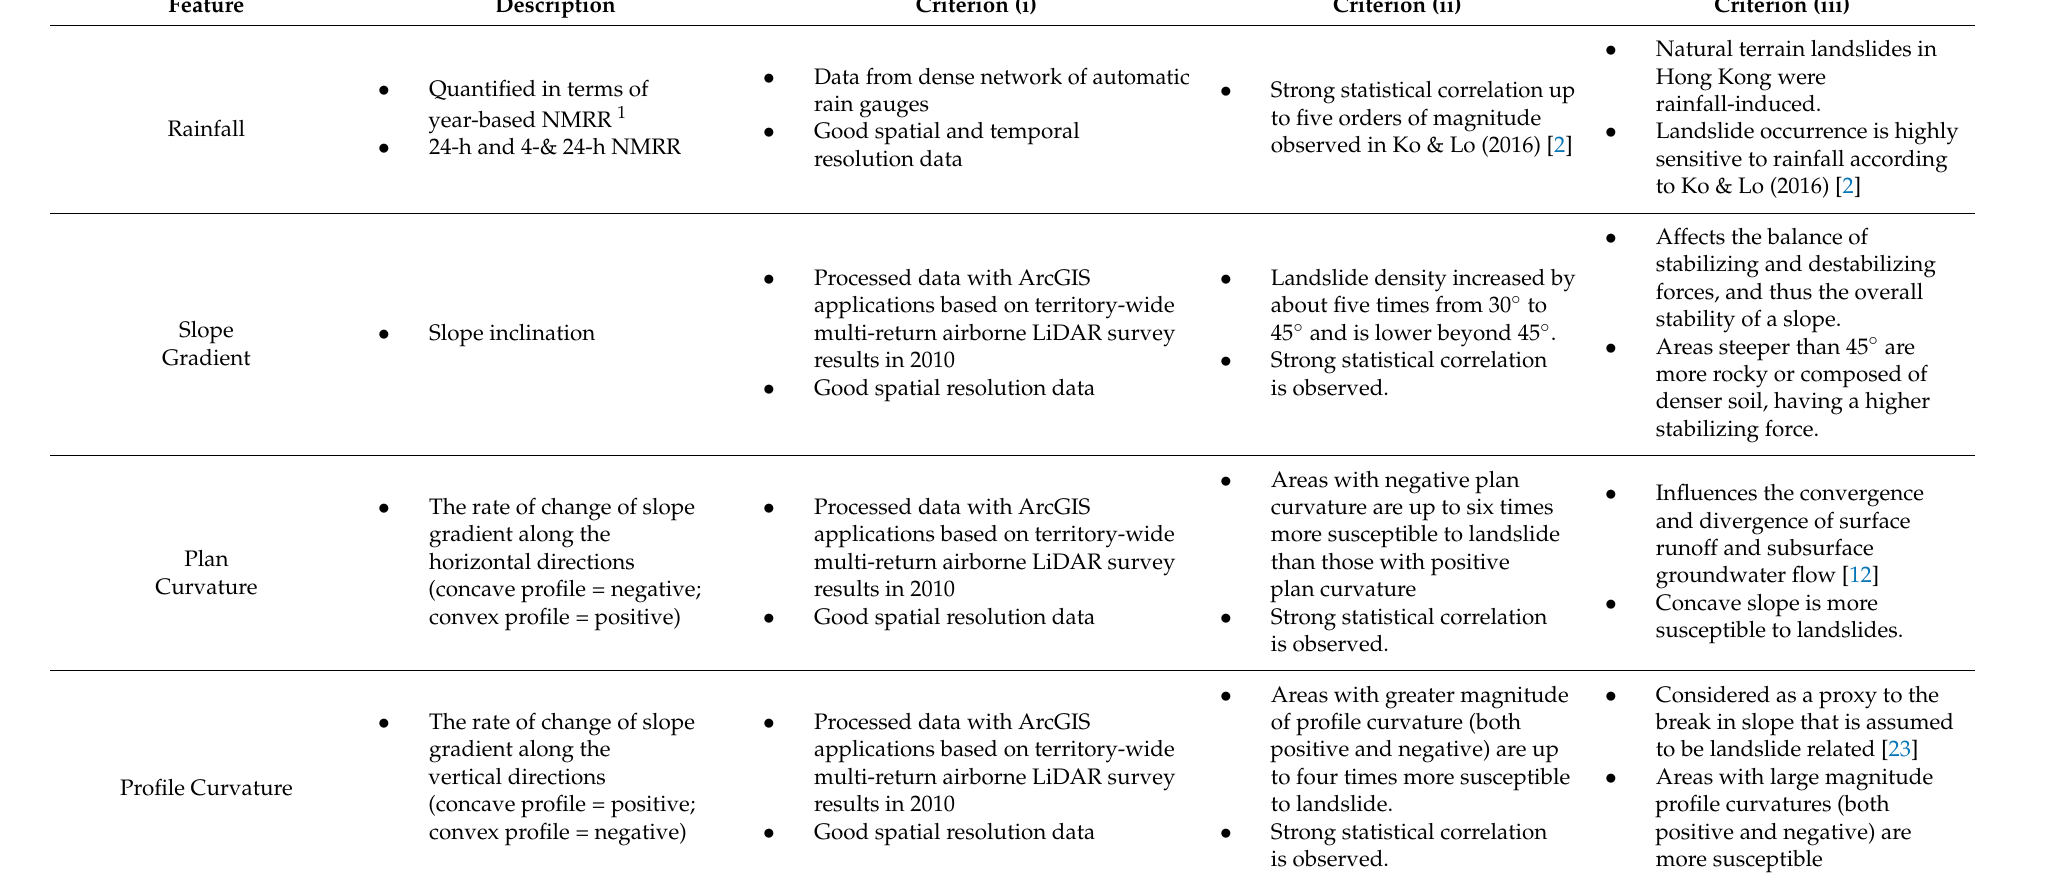
Table 4. Selected Features for the Pilot